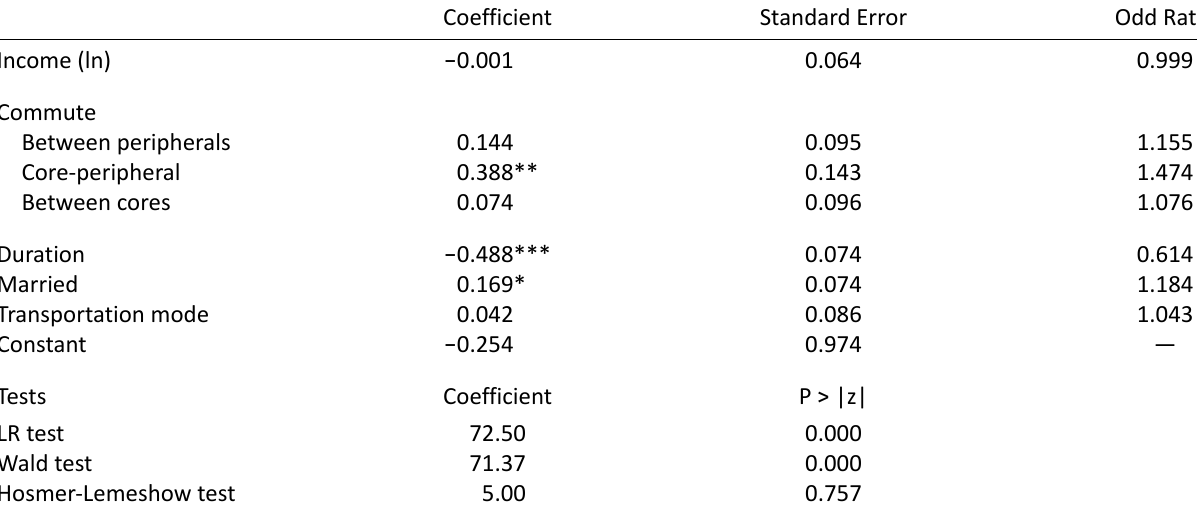
Table 9. Odds ratio of logistic regression of commuters’